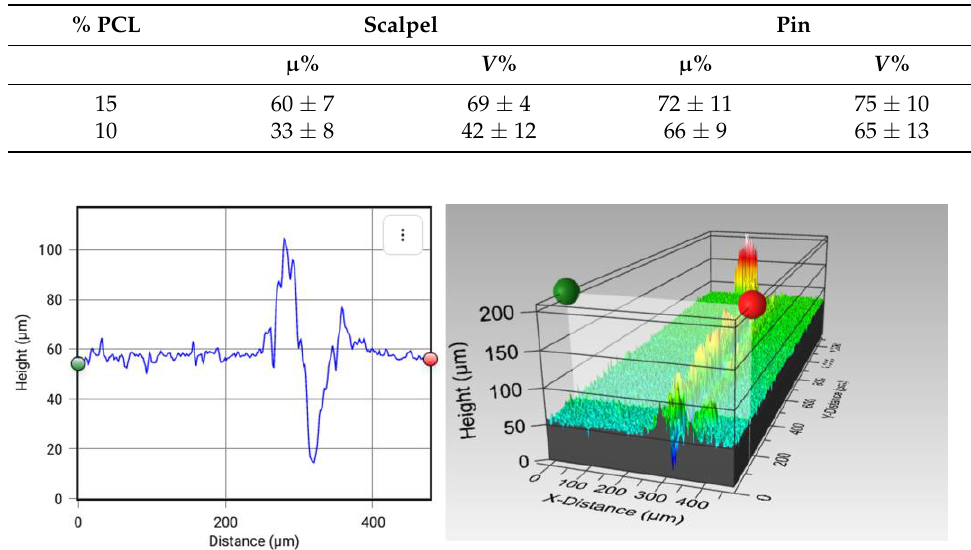
Figure 9. Image of the initial crack using a pin.